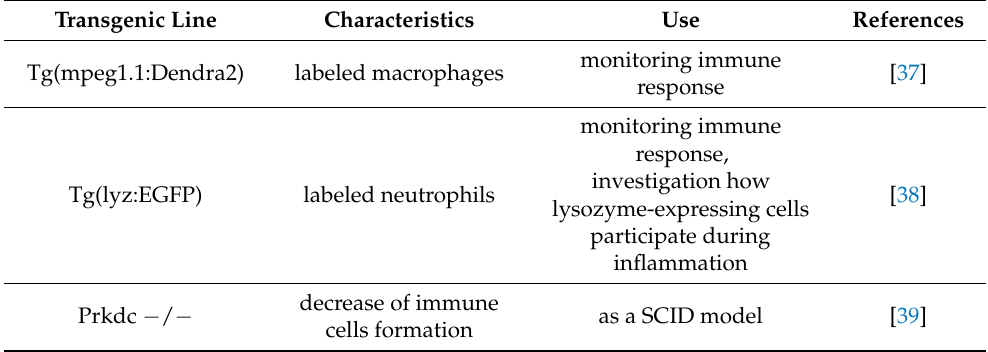
Table 1. Selected zebrafish transgenic lines commonly used in human disease